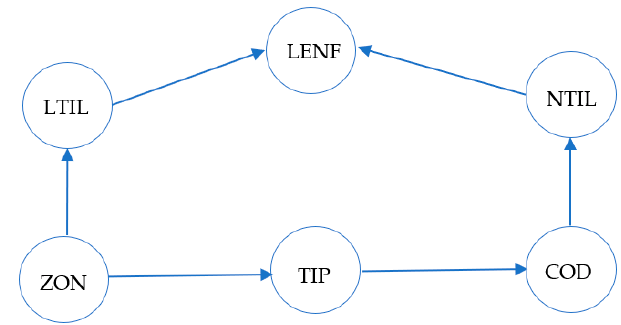
Figure 9. Probabilistic graphical model for house generation.